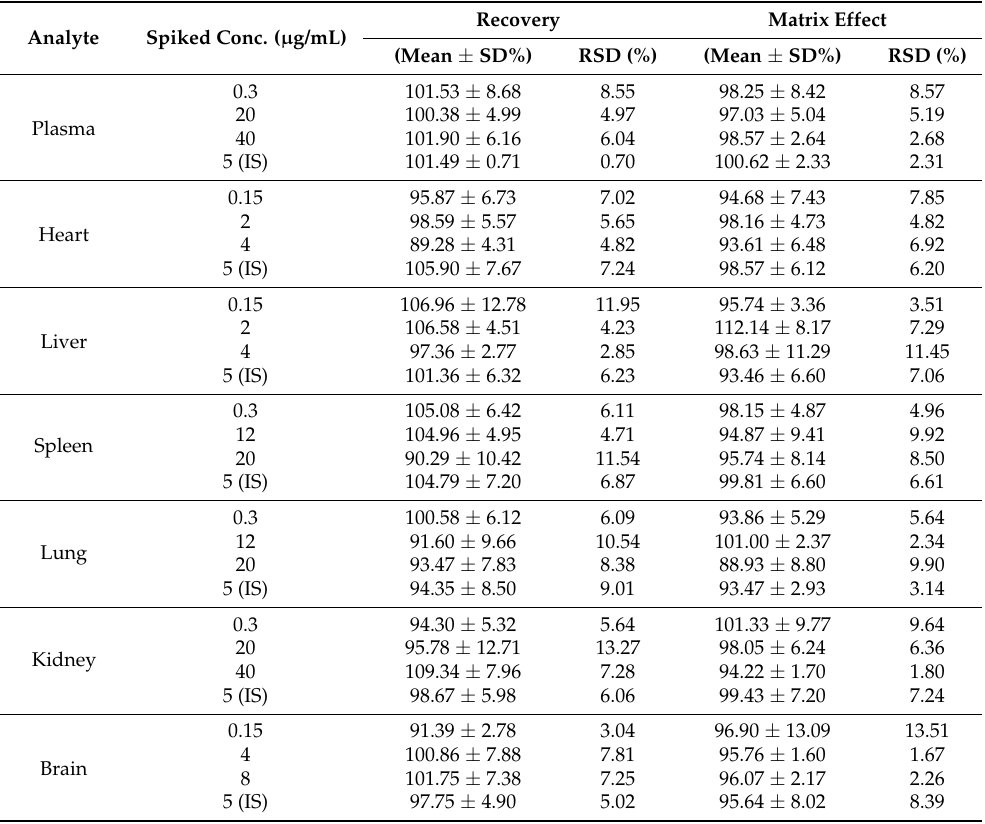
Table 4. Recovery and matrix effect of acipimox in plasma and tissue of rats ( n = 6